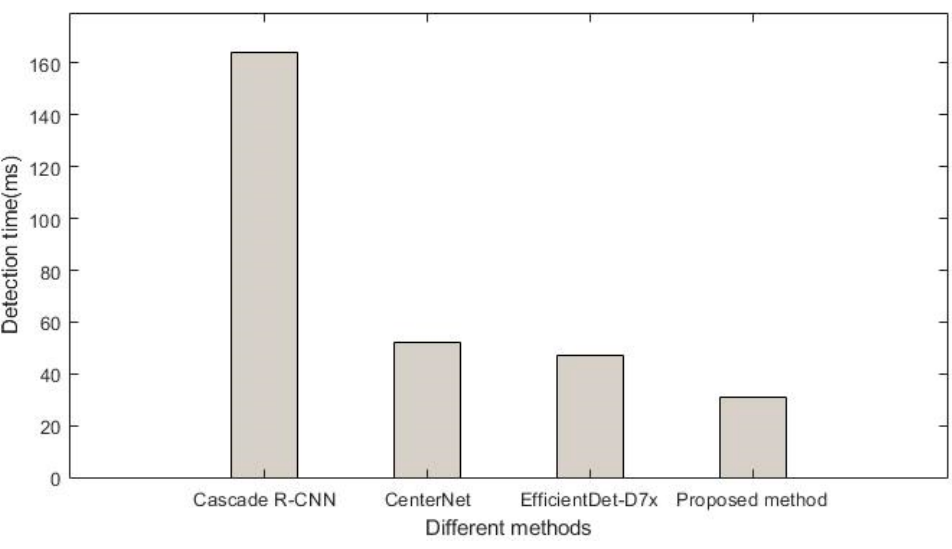
Figure 7. Detection time of four different methods.